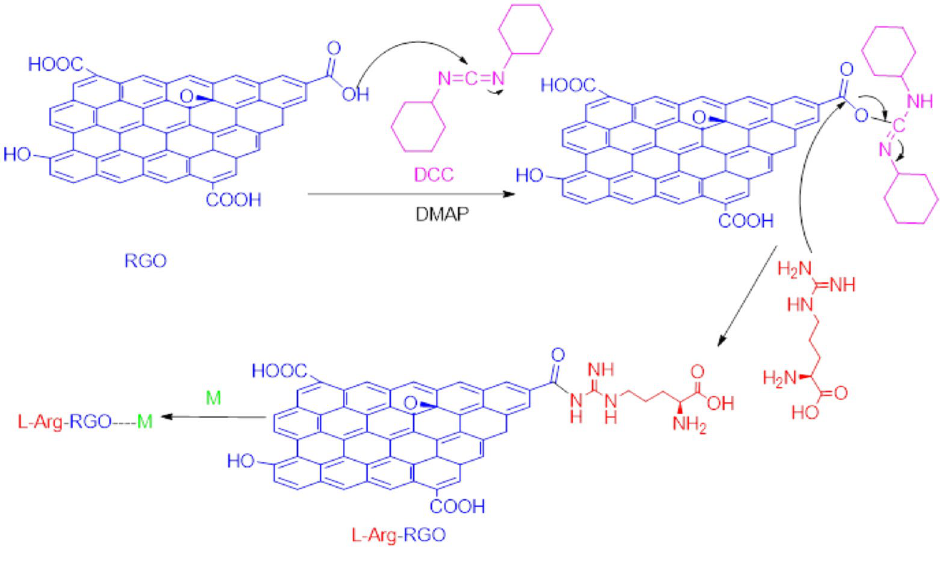
Figure 1. Synthesis of